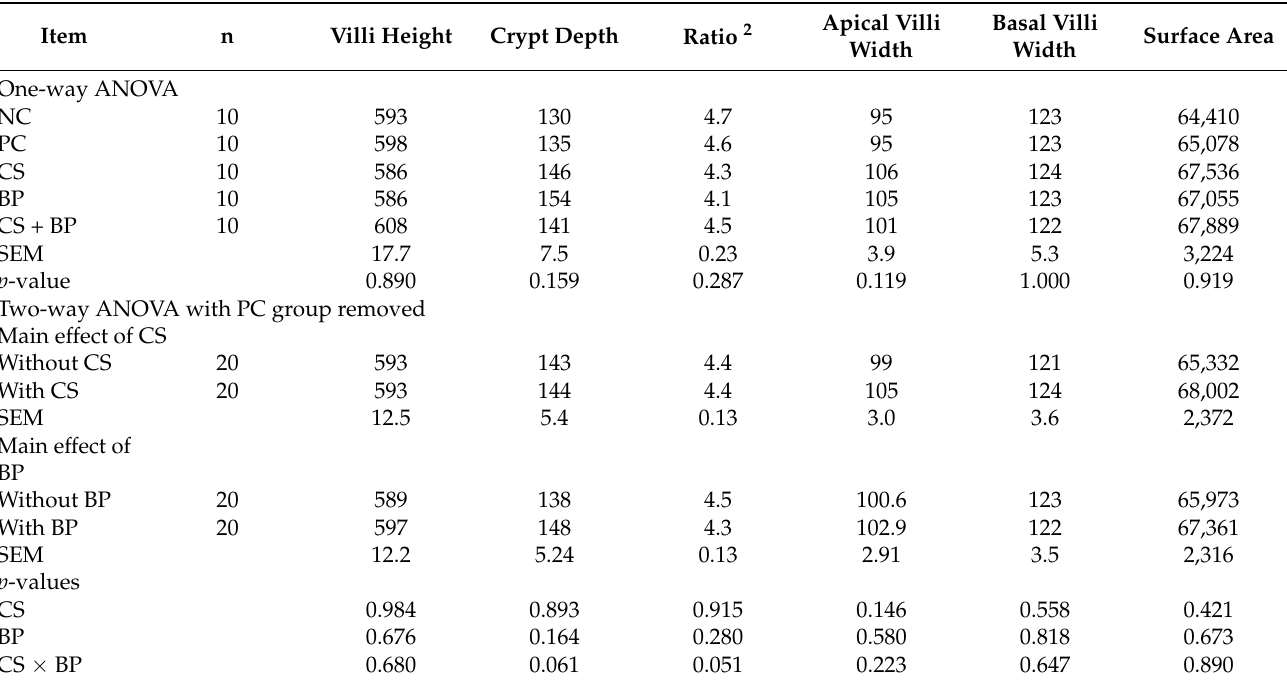
Table 8. Histological characteristics of ileal tissue collected from broilers fed diets with and without bacitracin methylene disalicylate or various antibiotic alternatives 1